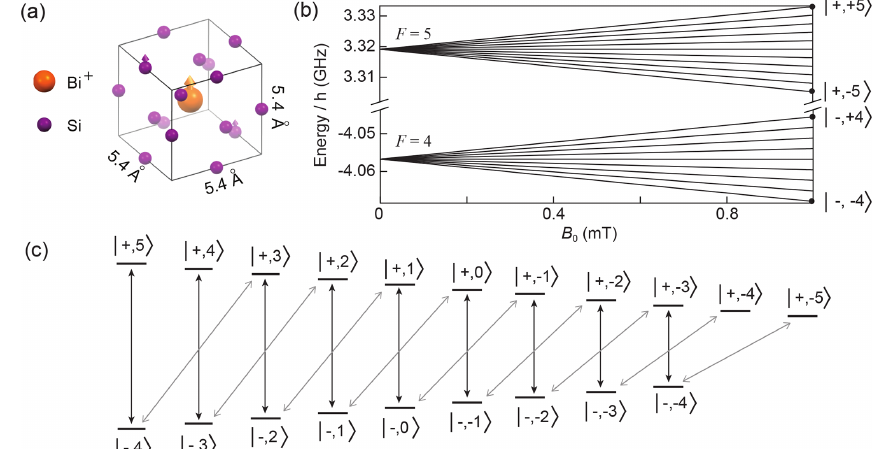
Figure 4. Structure and energy diagram of bismuth donors in silicon. (a) Silicon crystal structure, showing a substitutional bismuth atom coupled to nearby 29 Si nuclear spins. The donor electron is trapped around the Bi + ion and its wave function covers many lattice sites. (b) Energy levels of the bismuth donor for B 0 < 1mT. (c ) Schematic representation of the allowed transitions (black and grey arrows) between the bismuth donor energy levels in the low field